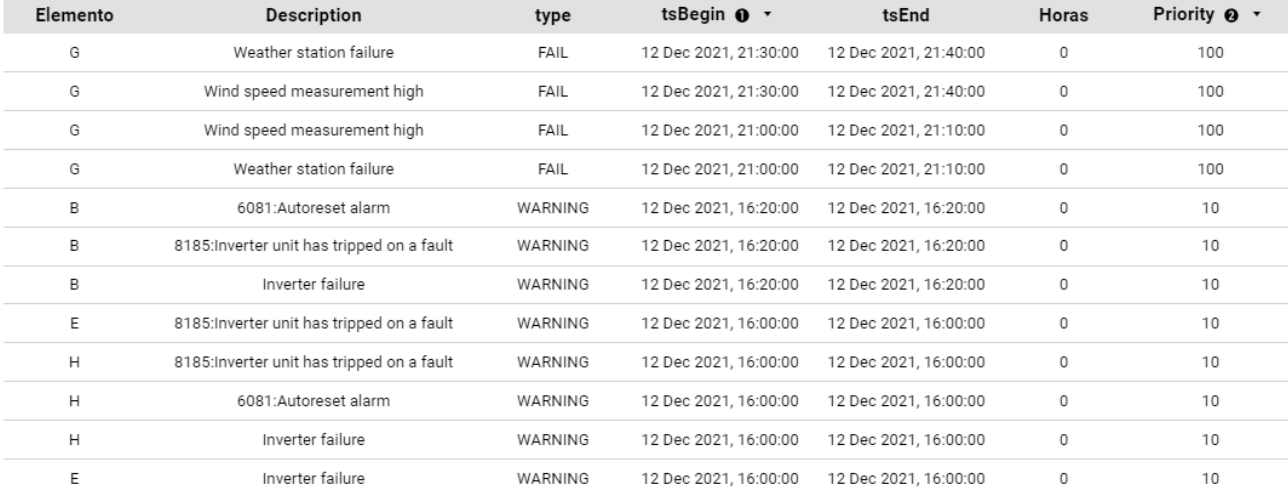
Figure 23. Chronology of daily alarms by element for the test PV plant over the evaluation period.